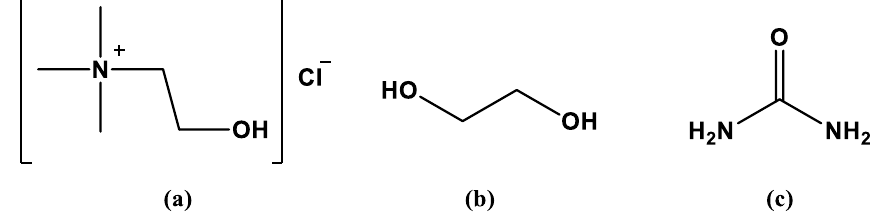
Figure 8. Chemical structures of ( a ) choline chloride, ( b ) ethylene glycol, and ( c ) urea.